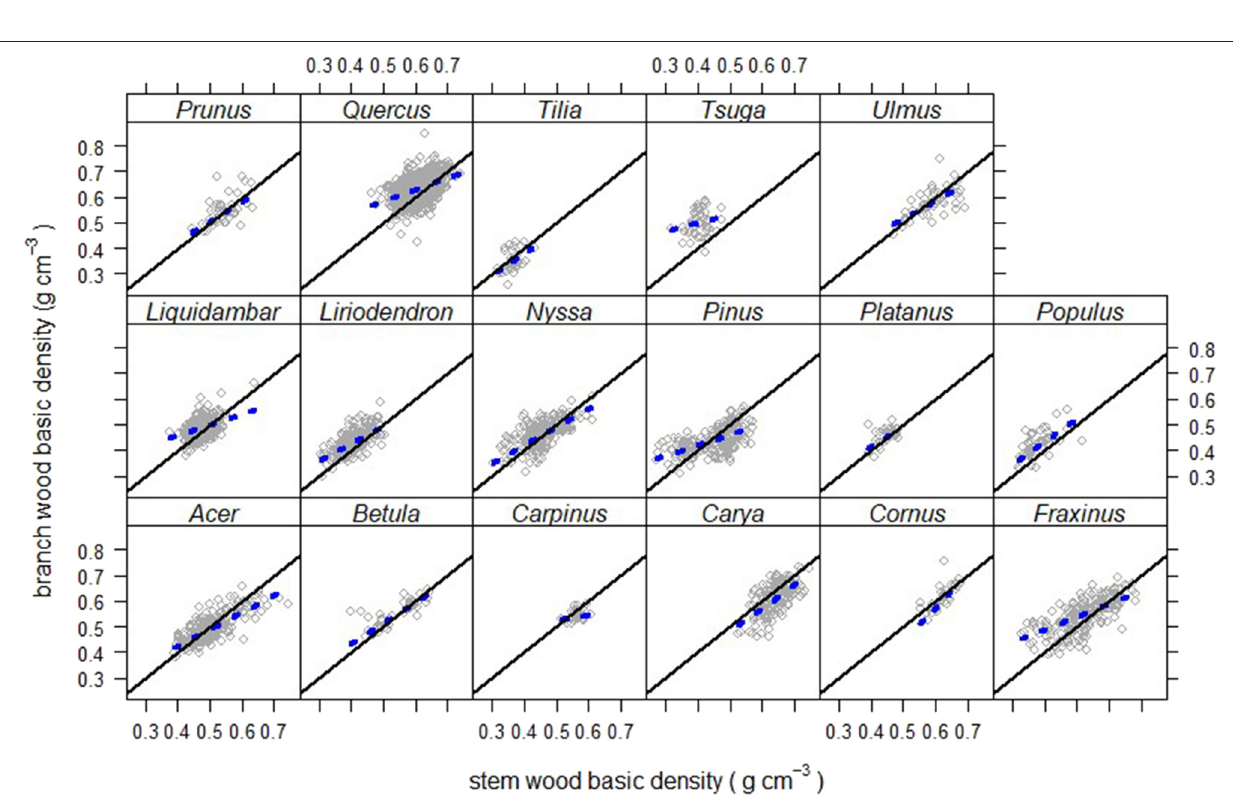
Frontiers in Forests and Global Change |